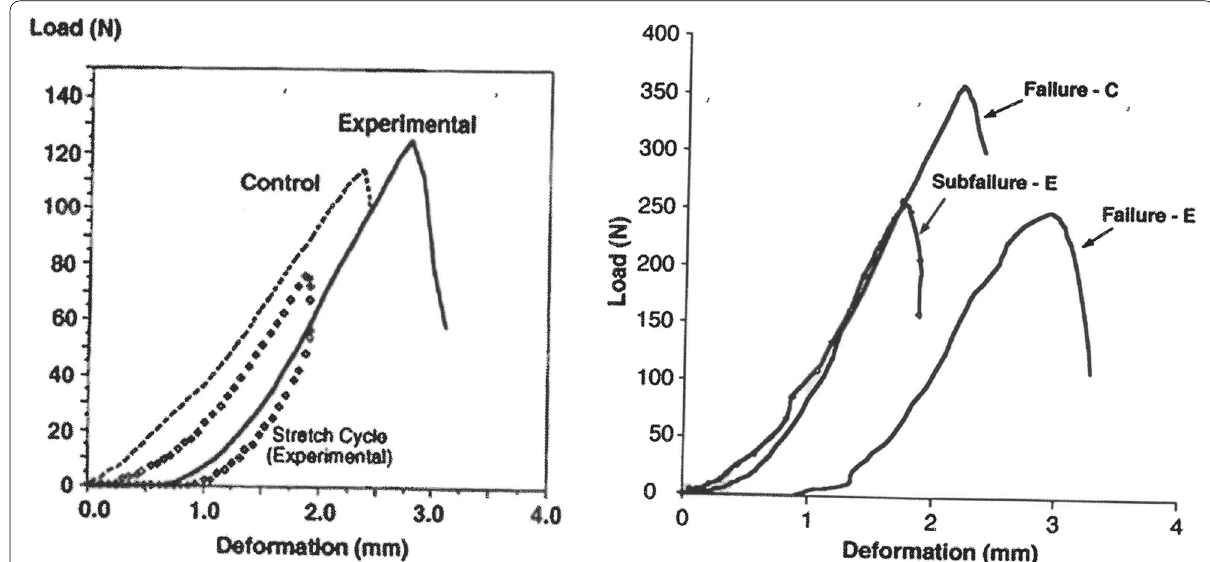
Fig. 3 A Load deformation curves until failure of a typical pair of experimental and control ligaments with the load and unloading curves of the experimental ligament (hysteresis) for the 80% subfailure stretch [74]; and B Representative load deformation curves for experimental (E) and control (C) ligaments. Also shown is the load deformation curve of the 80% subfailure stretch of the experimental ligament (subfailure – E) [73]. Findings confirm impairment in both submaximal hysteresis patterns and deformation under failure loads for the partially injured ACL. Figures used with permission [73,